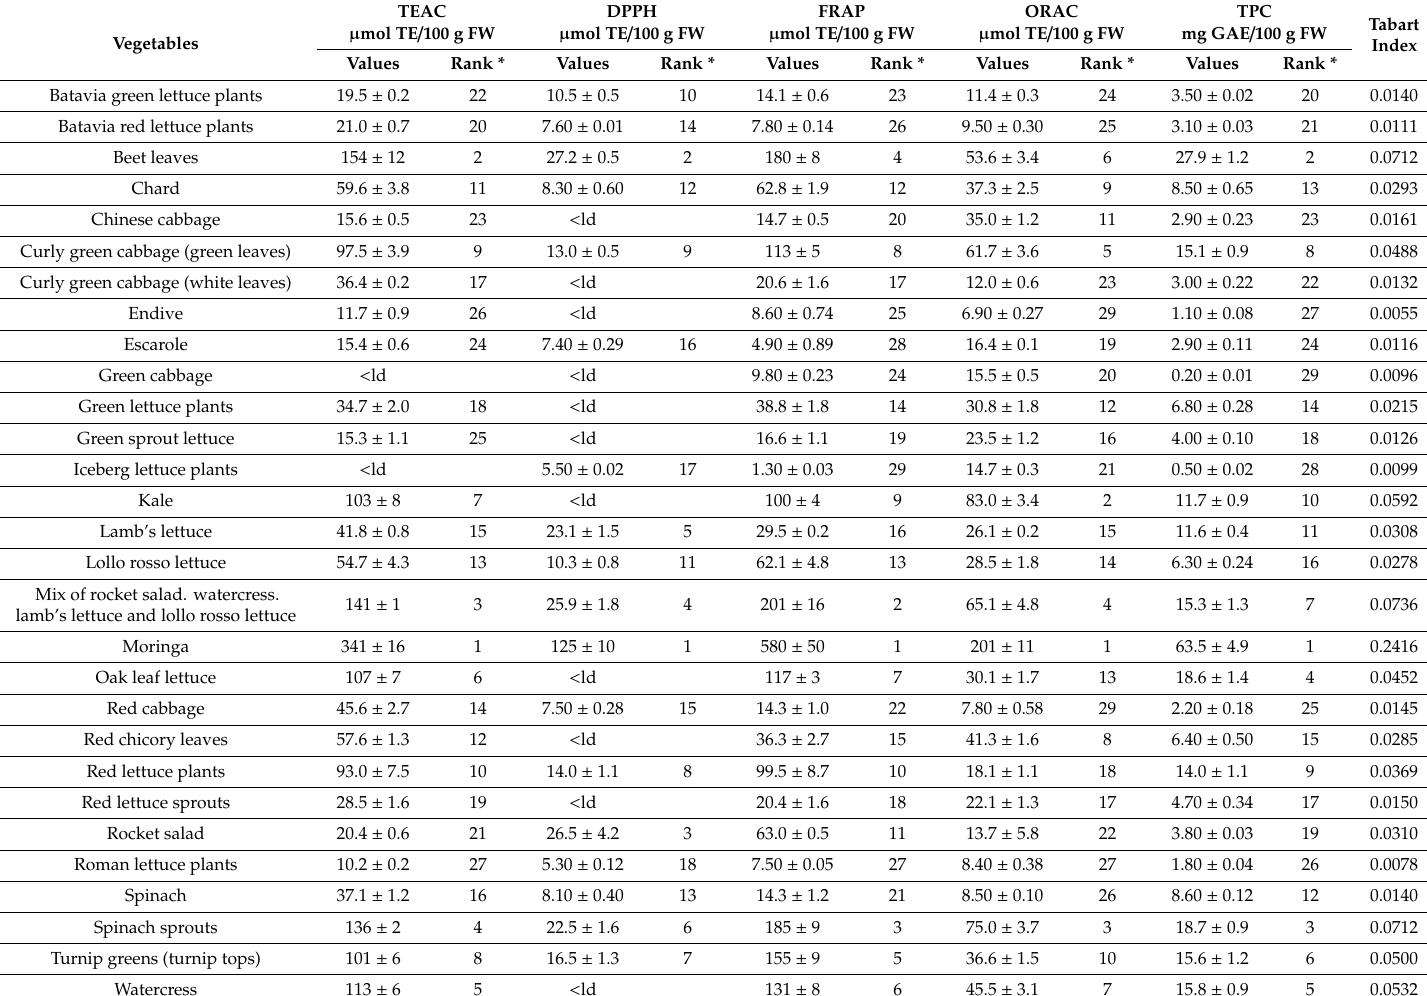
Table 3. Mean values of total antioxidant capacity and total polyphenol content of lipophilic extract (LE) according to the extraction method described by Prior et al., 2003 (14)